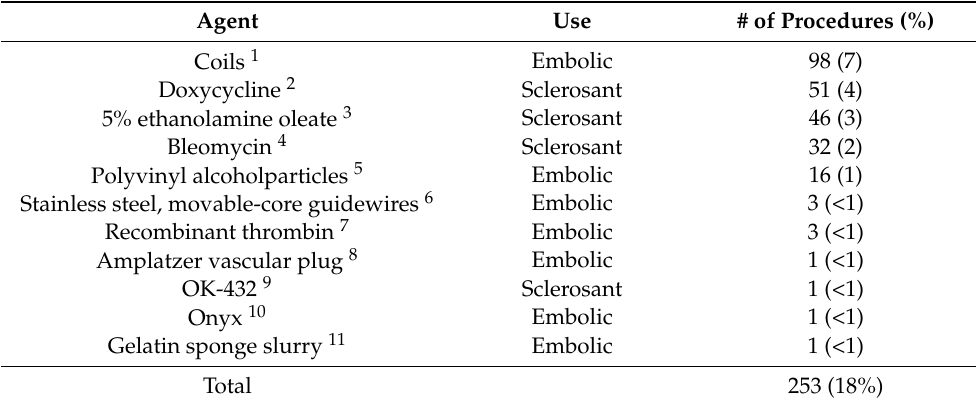
Table 2. Additional agents not combined with EPO.